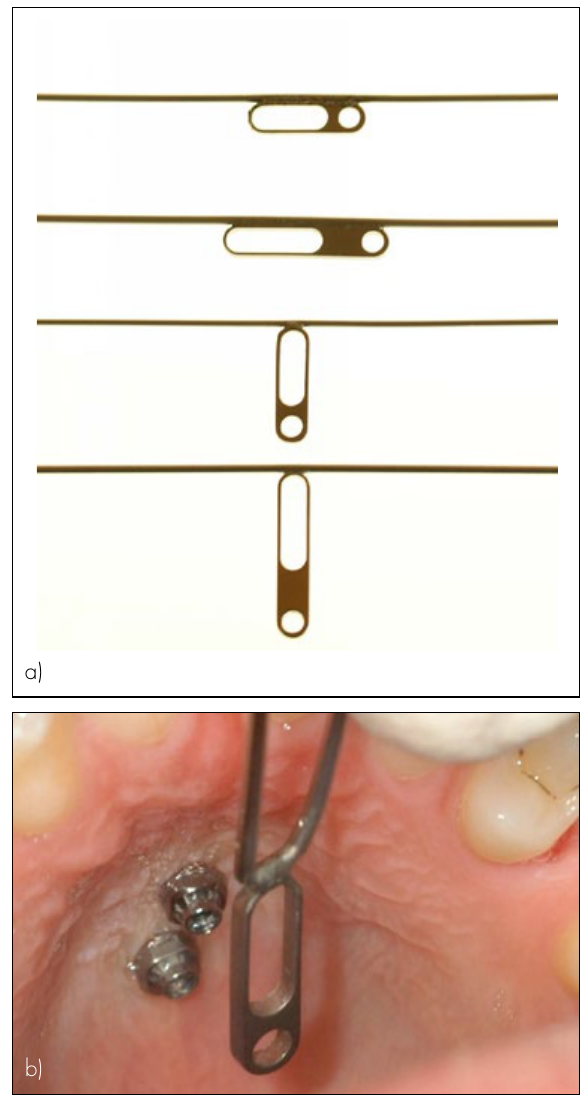
Figure 3. Beneplate system: Long and short Beneplates (a) with wires in place (0.032”) at the long side (for paramedian insertion) and at the short side of the plate (for median insertion). Fixation of a Beneplate on top of two mini-implants (b).